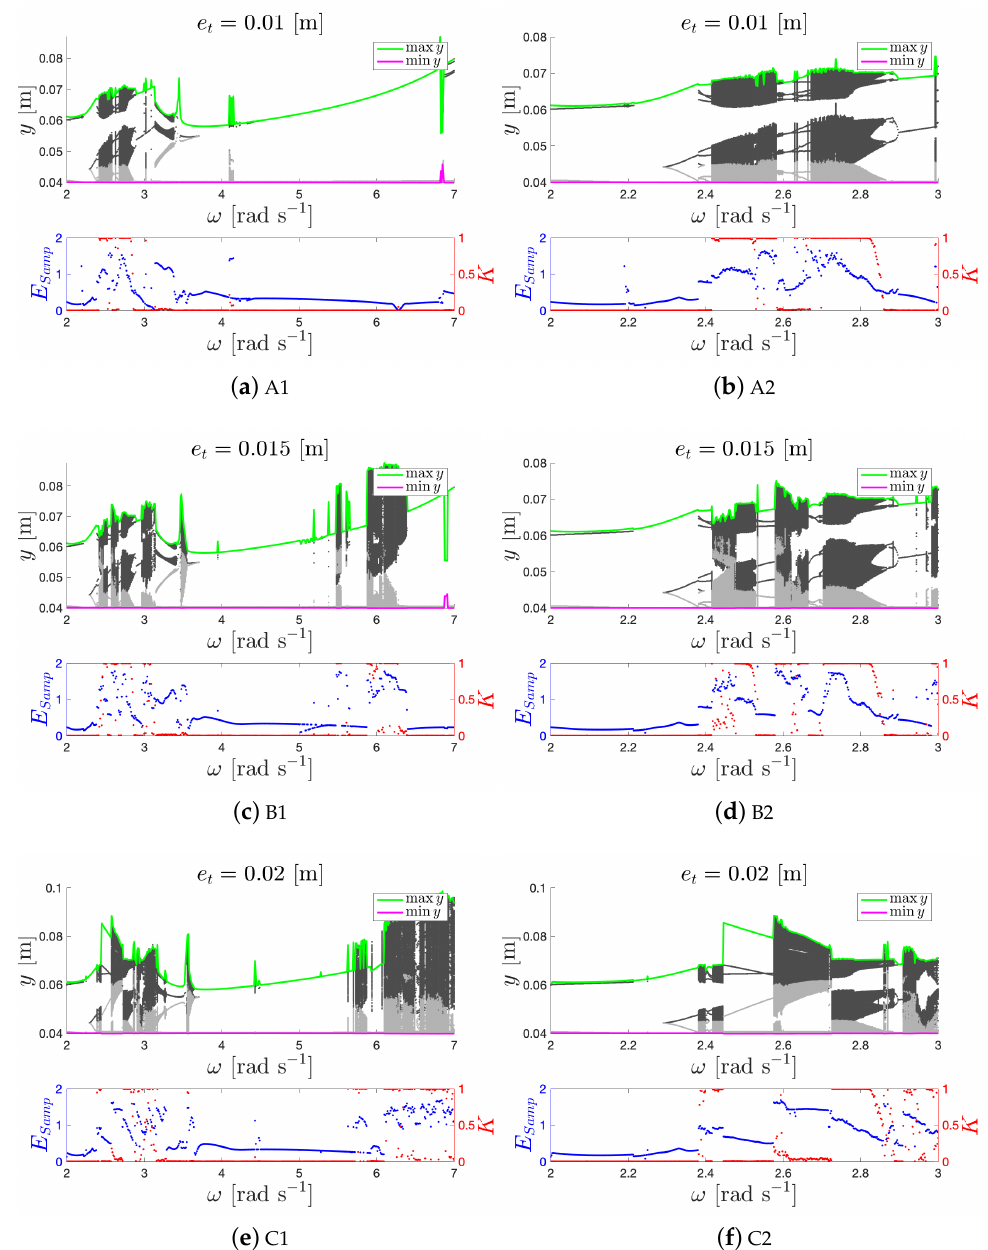
Figure 17. Bifurcation diagrams and outputs of the 0–1 test for chaos K and sample entropy E Samp of y for z a = 0.008 m with respect to the excitation frequency ω rad s − 1 of the sliding body: the first- column cases correspond to ω ∈ [ 2,7 ] rad s − 1 while the second-column cases to their magnifications ω ∈ [ 2,3 ] rad s − 1 , and “A”, “B”, “C” to eccentricity e T of 0.01 m, 0.015 m, and 0.02 m,